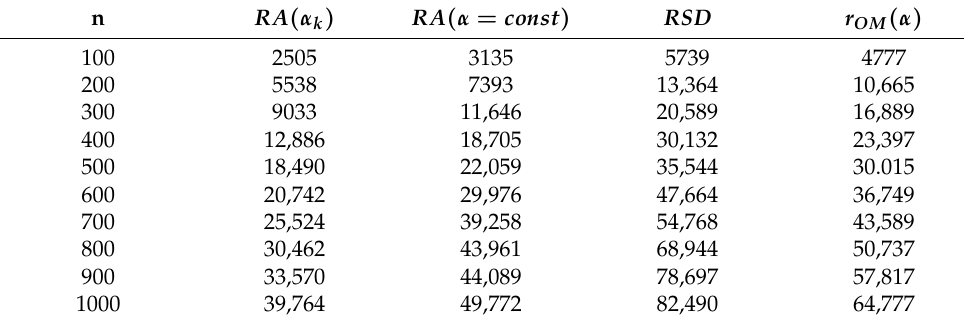
Table 5. Function f 4 ( x ) minimization results with subgradient distortion.